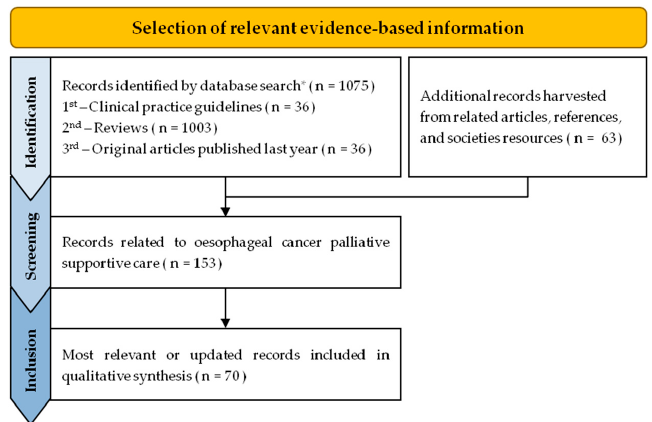
Figure 1. Flowchart of selection of relevant evidence‑based information on palliative supportive care of oesophageal cancer. * PubMed search heading: ((supportive care) OR (palliative)) AND ((oe‑ sophag *) OR (esophag *)) AND ((cancer) OR (carcinoma)), last executed on 25 August